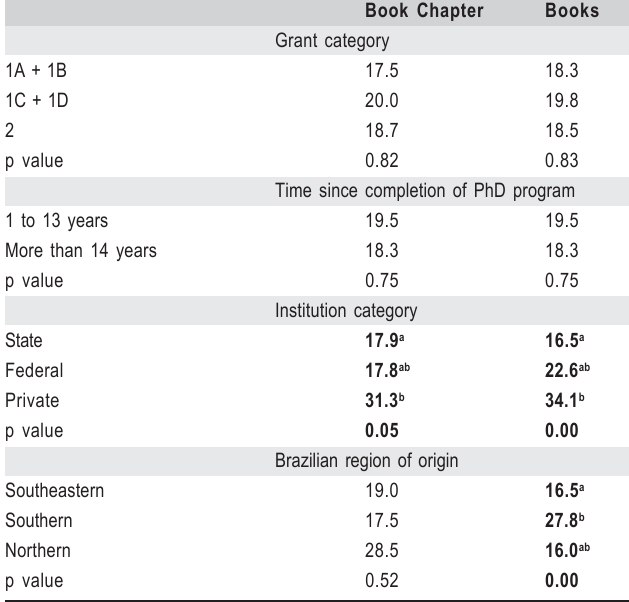
Table 5. Number of published book chapters and